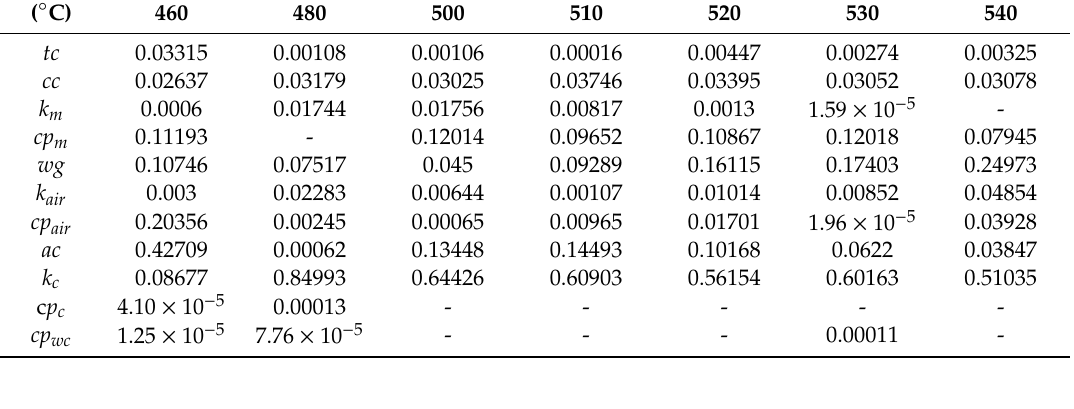
Table 5. Impact factors for the HTC at the casting–core interface for p < 0.05.